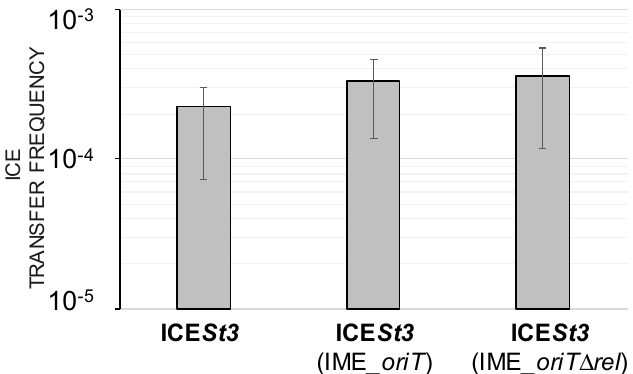
Figure 5. Frequencies of ICE St3 transfer observed when the ICE does not host an IME_ SsalL25 _ oriT or hosts a wild-type IME_ SsalL25 _ oriT or an IME deleted for its relaxase gene (IME_ SsalL25 _ oriT ∆ rel ). Results were obtained from four independent biological replicates.